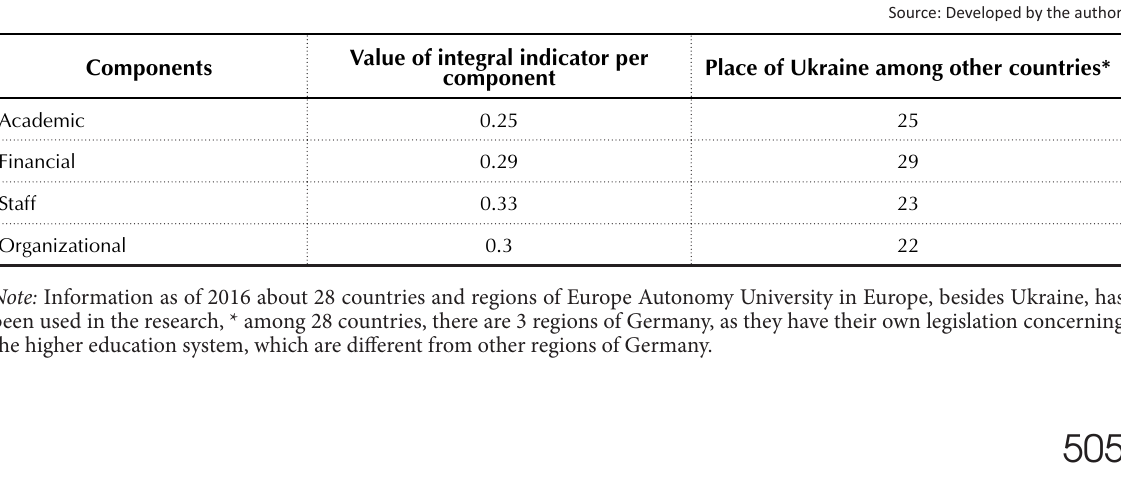
Table 1. Integral values of the autonomy components of the Ukrainian higher education